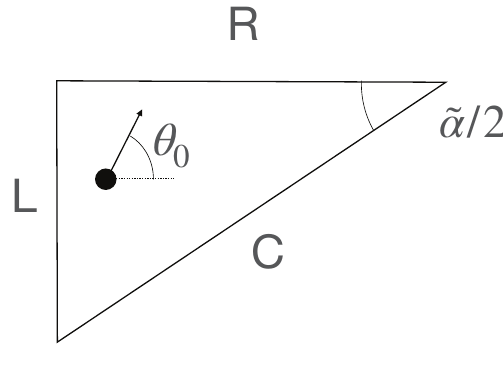
gives the orientation 0